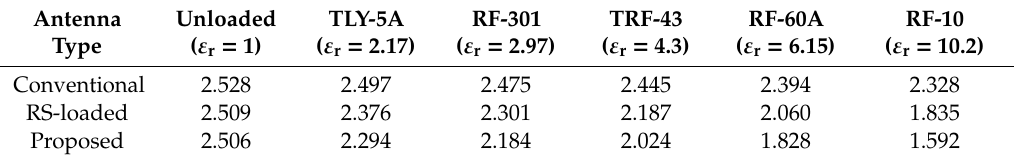
Figure 11. Measured S 11 characteristics of the three MPSAs for the MUTs in Table 2: ( a ) conventional MPSA; ( b ) RS-loaded MPSA; and ( c ) proposed MLS-loaded MPSA. Table 4. Measured first resonant frequencies of S 11 responses for the three MPSAs in GHz.